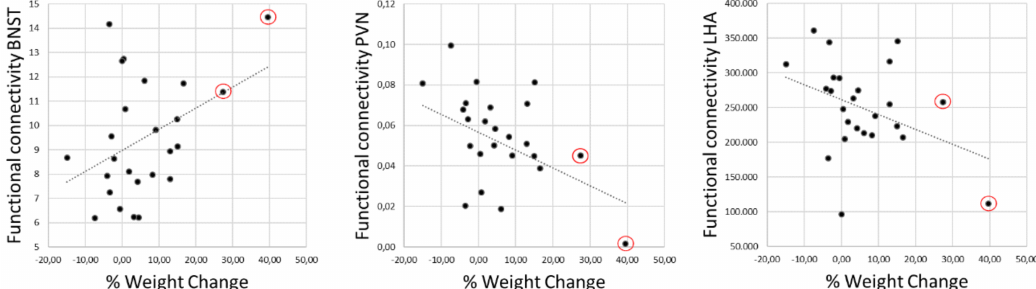
Figure 2. Pearson’s correlation analysis of weight changes with functional connectivity estimates between individual stimulation volumes and bed nucleus of the stria terminalis (BNST), paraventricular nucleus (PVN), and lateral hypothalamic area (LHA). All regions revealed significant correlations with weight changes (BNST: r = 0.420, p = 0.018; PVN: r = –0.405, p = 0.016; LHA: r = − 0.384, p = 0.028) that remained significant after correction for multiple comparisons. Of note, two patients experienced an excessive weight gain of over 25% (marked in red